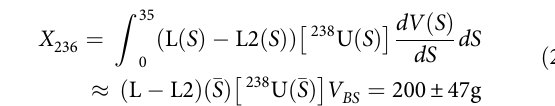
(cid:1) S Þ = (1.02 ± 0.24) × 10 − 8